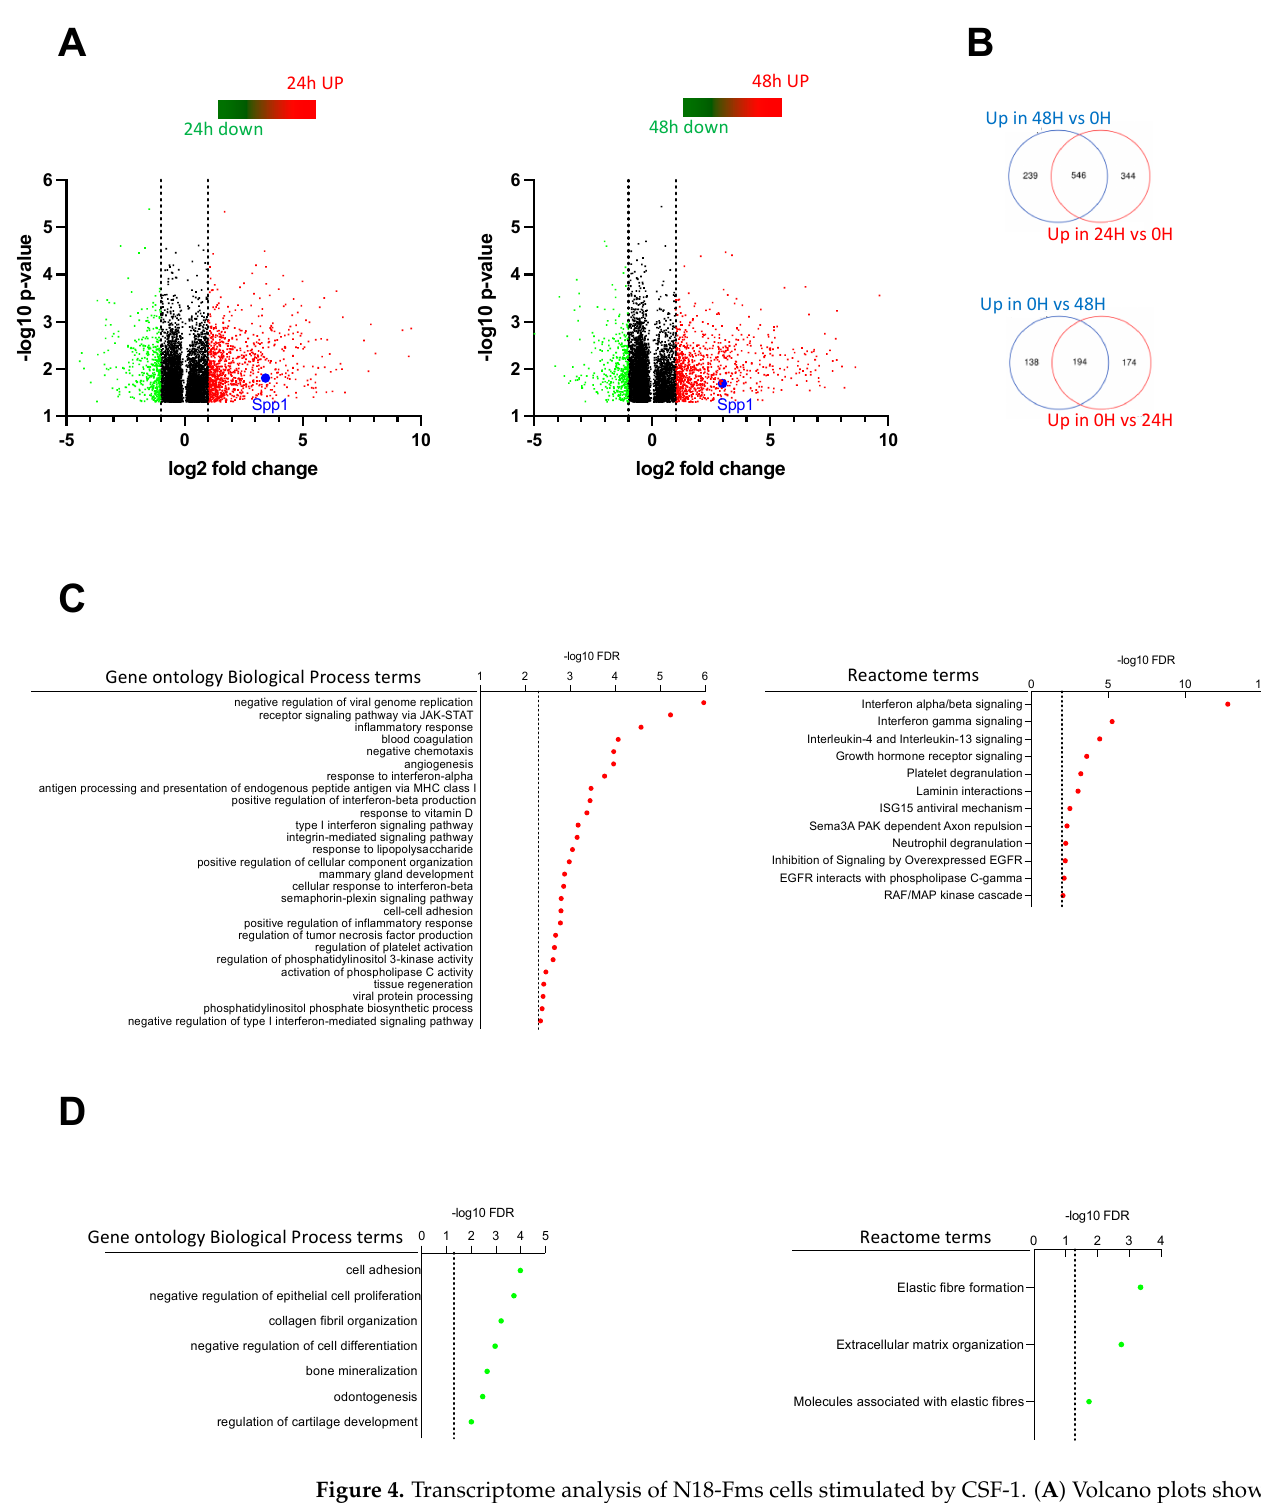
Figure 4. Transcriptome analysis of N18-Fms cells stimulated by CSF-1. ( A ) Volcano plots showing all genes differentially expressed with p < 0.05 when comparing 24 h (left plot) and 48 h (right plot) of CSF-1 treatment with untreated control (0 h) (N = 2 for each group). Genes upregulated and downregulated with a fold change of 2 (shown by the grey line) or more after treatments are shown by red and green dots, respectively. The Spp1 gene is shown by a blue dot. ( B ) Venn diagram showing the intersection between genes upregulated (upper diagram) and downregulated (lower diagram) by the 24 h and 48 h CSF-1 treatments when compared to the untreated control. ( C ) Genes upregulated in both 48 h and 24 h of CSF-1 treatment when compared to untreated control (as shown in B) were subjected to a gene ontology enrichment analysis using the GO Biological Process (left panel) and Reactome terms (right panel). The –log10 of the FDR is shown for each enriched term with a FDR < 0.005 for Biological Process terms and a FDR < 0.01 for Reactome terms (shown by the dotted line). These thresholds were chosen for clarity purpose and the complete list of enriched terms is shown in Supplementary Table S1. ( D ) Same as in ( C ) using the genes downregulated in